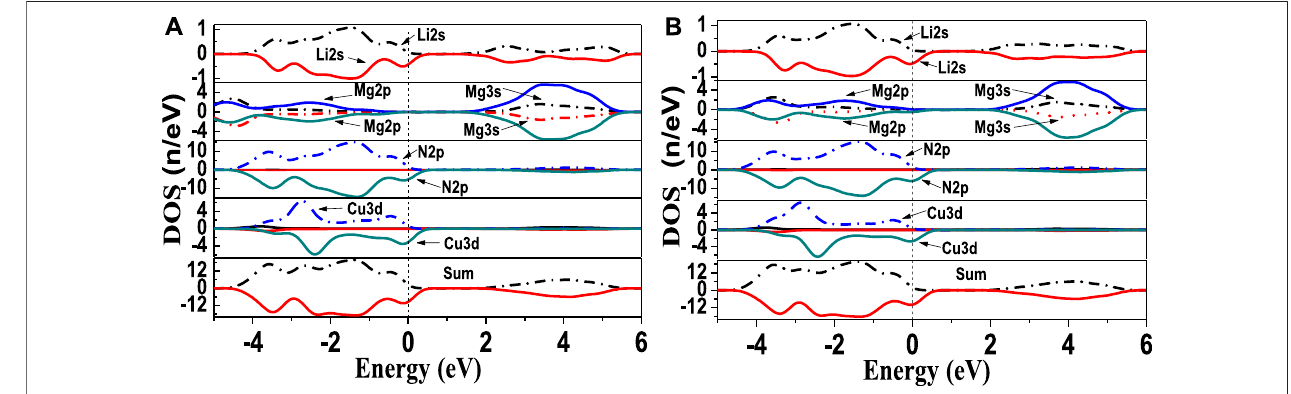
FIGURE 4 | The density of states of Li(Mg 0.875 Cu 0.125 )N (A) ; Li 0.9375 (Mg 0.875 Cu 0.125 ) (B) .